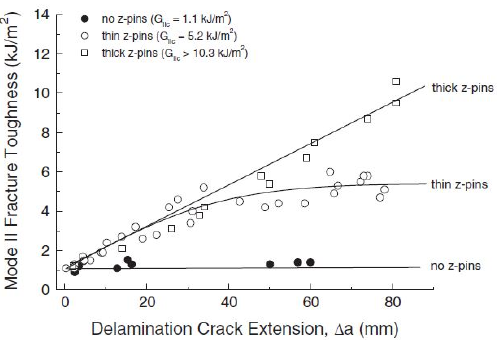
Figure 61. E ff ect of z-Pin diameter on the mode II apparent fracture toughness of a z-Pinned laminate (CFRP z-Pins, 2.0 vol%, [0 6 [0 / 90] 2 ] s pre-preg) [27].